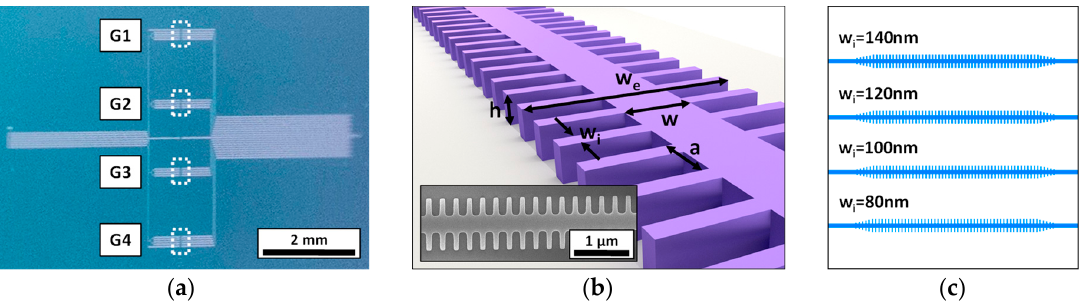
Figure 1. ( a ) Image of the fabricated photonic chip, where the different groups of 1D photonic crystal (PC) sensing structures are indicated. ( b ) Sketch of the 1D PC structure showing its main parameters. The inset shows a Scanning Electron Microscopy (SEM) image of one of the fabricated 1D PC sensing structures. ( c ) Distribution of the 1D PC structures within each sensors group.